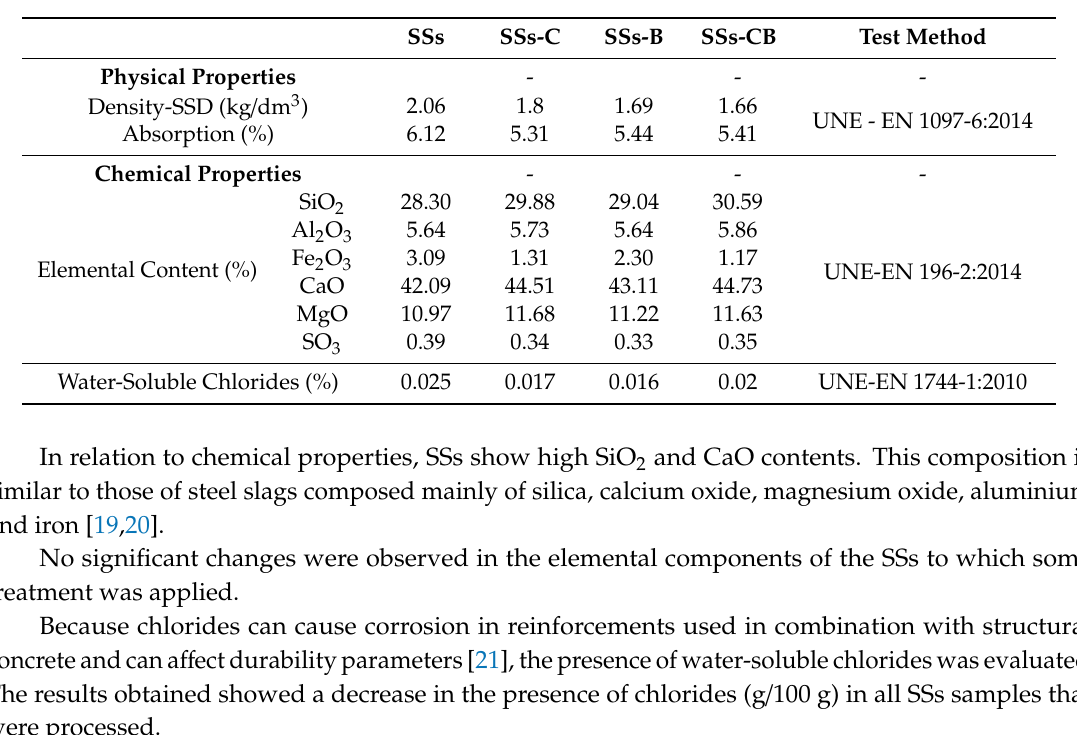
Table 1. Physical and chemical properties of SSs.